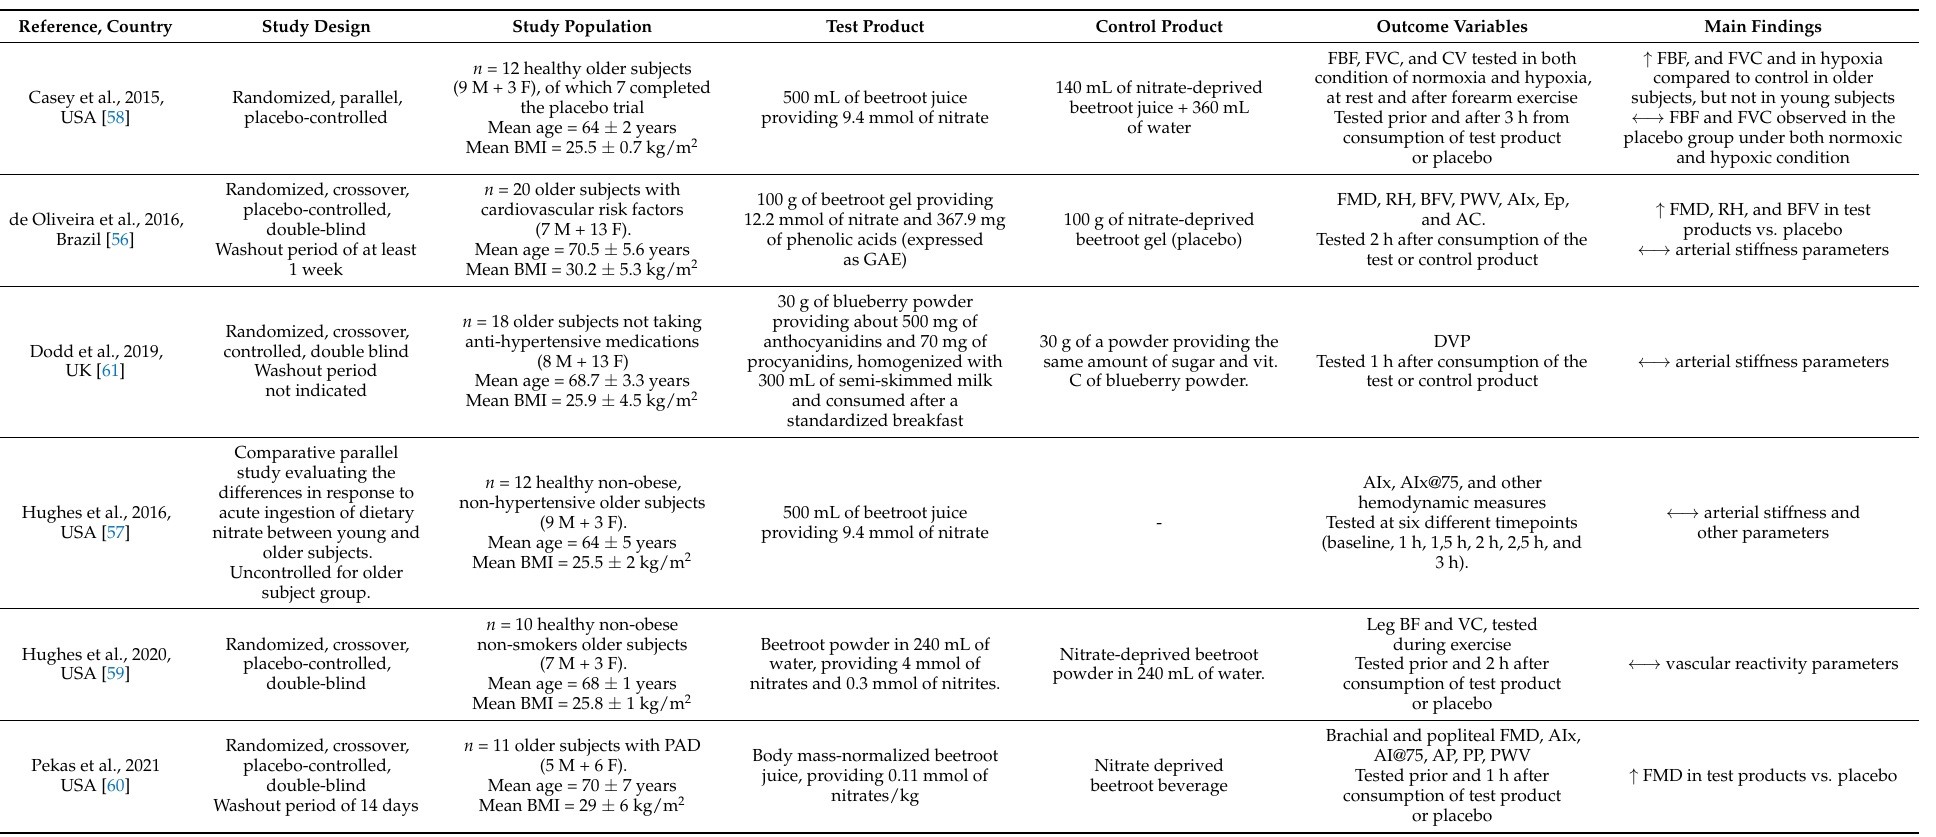
Table 1. Characteristics of the acute intervention studies investigating the effects of plant-food consumption on markers of vascular function in older